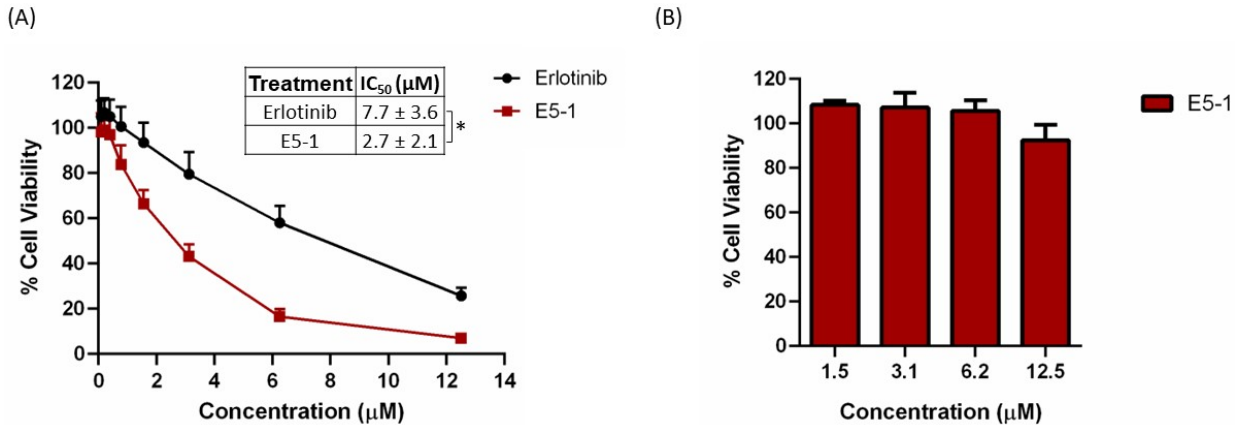
Figure 6. In vitro cytotoxicity study of E5-1 nanoemulsion ( A ) and drug-free nanoemulsion ( B ) in NSCLC A549 cells. Cells were treated at di ff erent concentrations (0.09 to 12.5 µM) for 72 h and cell viability was determined using MTT calorimetric assay. Data represented with mean ± SD (n = 6, for three independent trials), * p < 0.05.